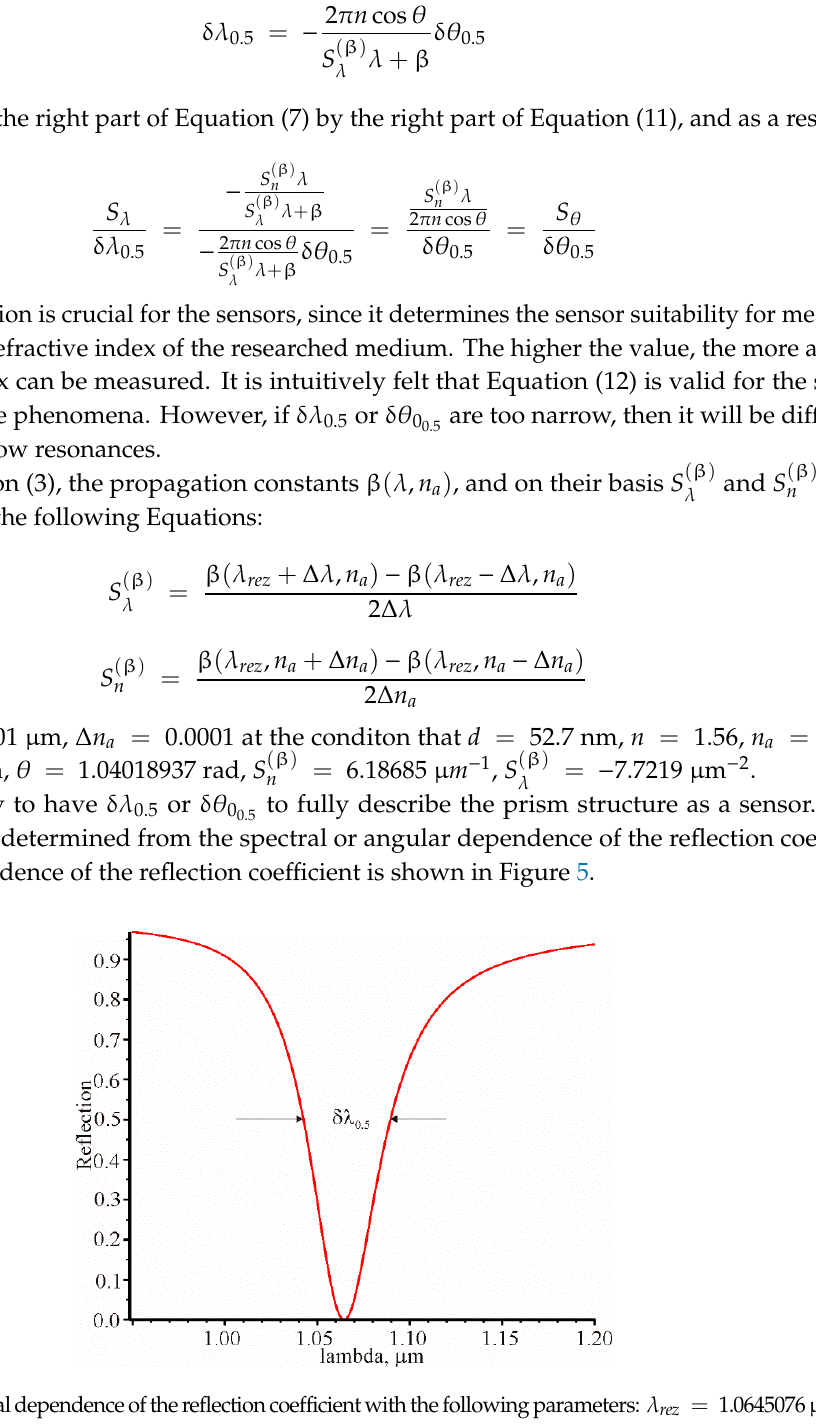
Figure 6. Angular dependence of the reflection coefficient with the following parameters: (cid:2016) (cid:3045)(cid:3032)(cid:3053) = 1.04018937, (cid:2019) (cid:3045)(cid:3032)(cid:3053) = 1.0645076 μ(cid:1865), (cid:1856) = 52.7 nm, (cid:1866) = 1.56, (cid:1866) (cid:3028) = 1.3242. In this case, δ(cid:2016) (cid:2868).(cid:2873) = 0.002609 rad . In order to verify the correctness of Equations (7), (9), (11) and (12), it is necessary to calculate (cid:1845) (cid:3090) . It should be calculated on the base of the resonant wavelength change at the given angle of incidence of the beam, with a slight change in the researched medium refractive index. It can be done using the following equation: (cid:1845) (cid:3090) = (cid:2019) (cid:3045)(cid:3032)(cid:3053) (cid:4666)(cid:1866) (cid:3028) + ∆(cid:1866) (cid:3028) ) − (cid:2019) (cid:3045)(cid:3032)(cid:3053) (cid:4666)(cid:1866) (cid:3028) − ∆(cid:1866) (cid:3028) ) 2∆(cid:1866) (cid:3028)